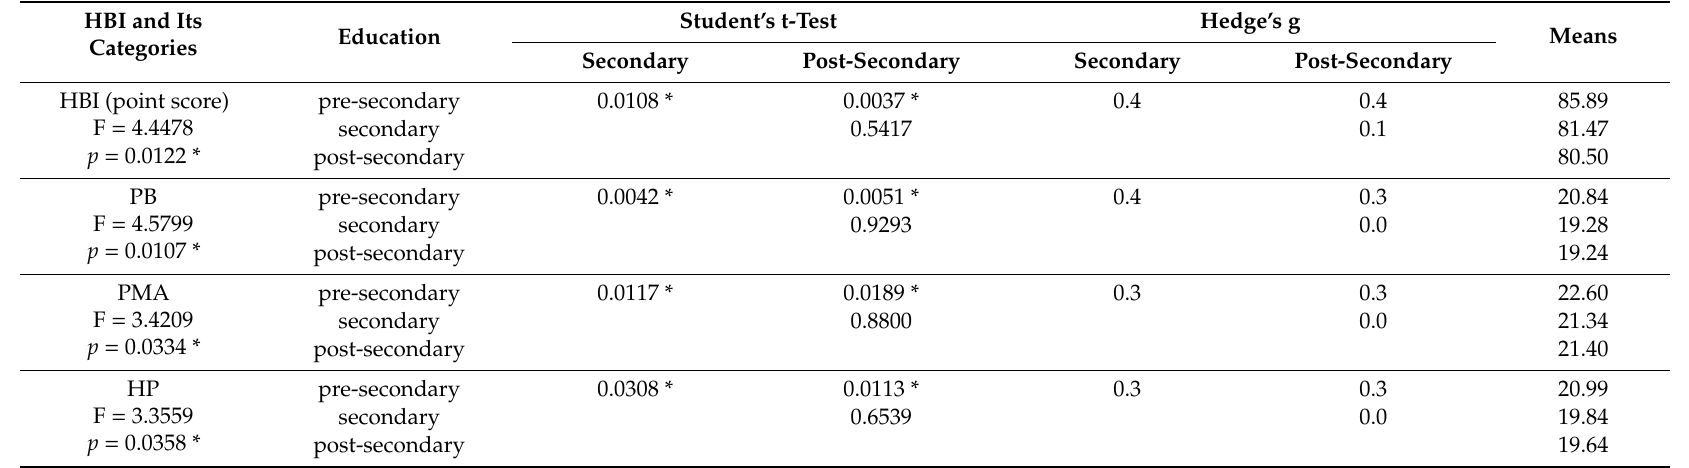
Table 6. Health behaviors of people who practice CS and MA, in relation to the level of education (F-test, Student’s t-test, Hedge’s g). HBI and Its